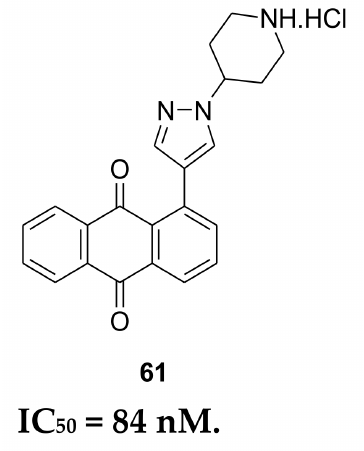
Figure 66. Structure of compound 61 , a PDK4